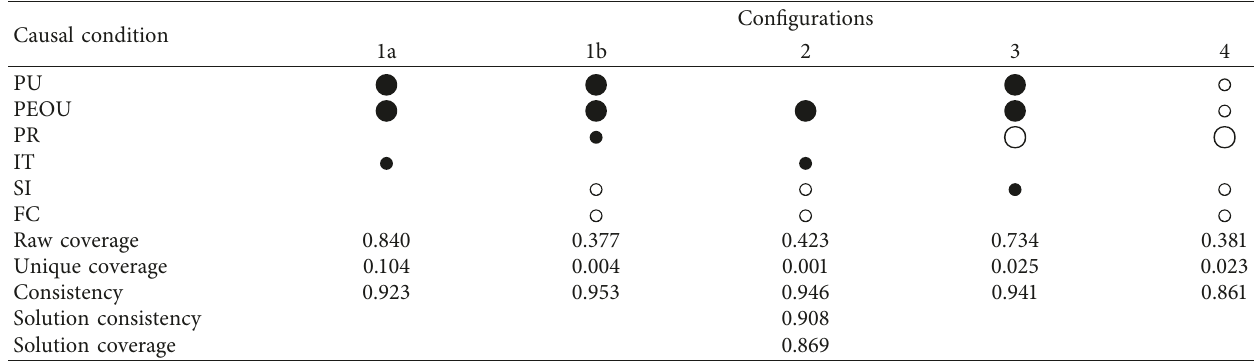
Table 10: Sufficient configurations for high CAVs adoption.